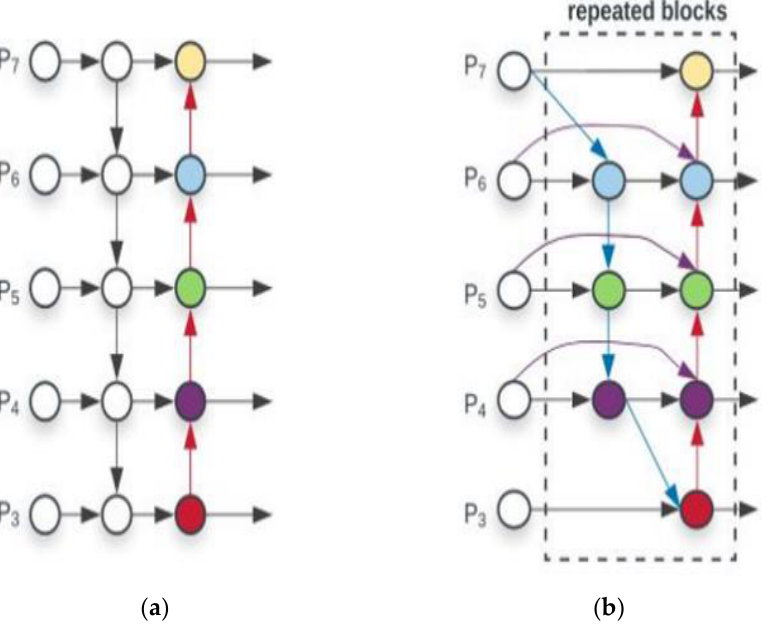
Figure 5. ( a ) for PANet, ( b ) for BiFPN. The color represents the multi-scale feature representation of the previous P3-P7 fusion.